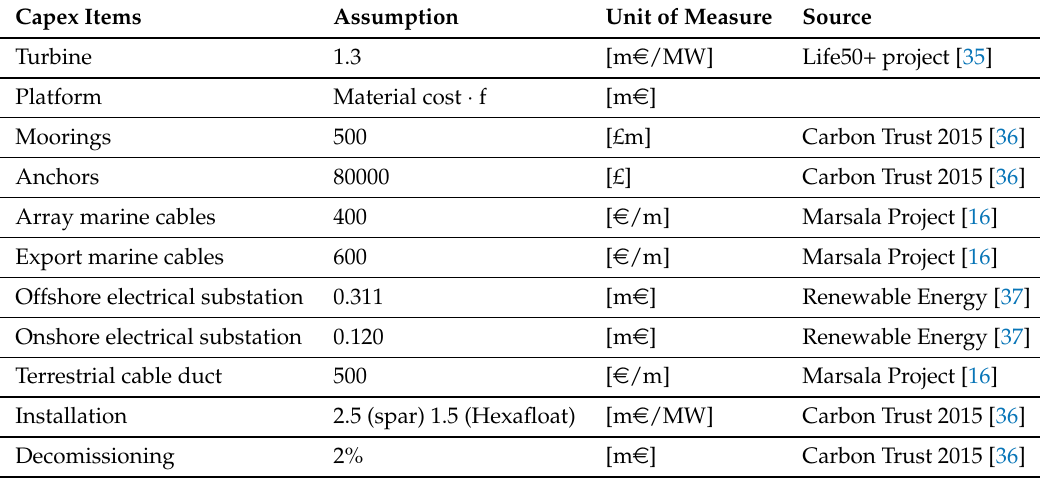
Table 6. Assumptions for Pantelleria’s offshore wind